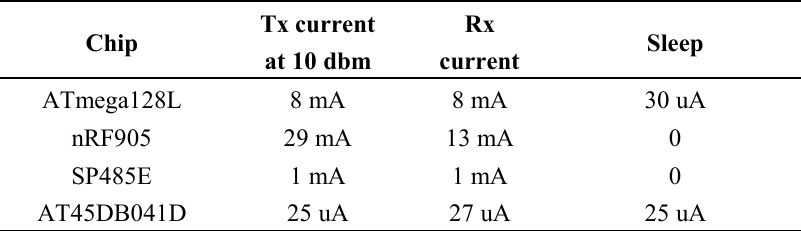
Table 3. Average current of the data